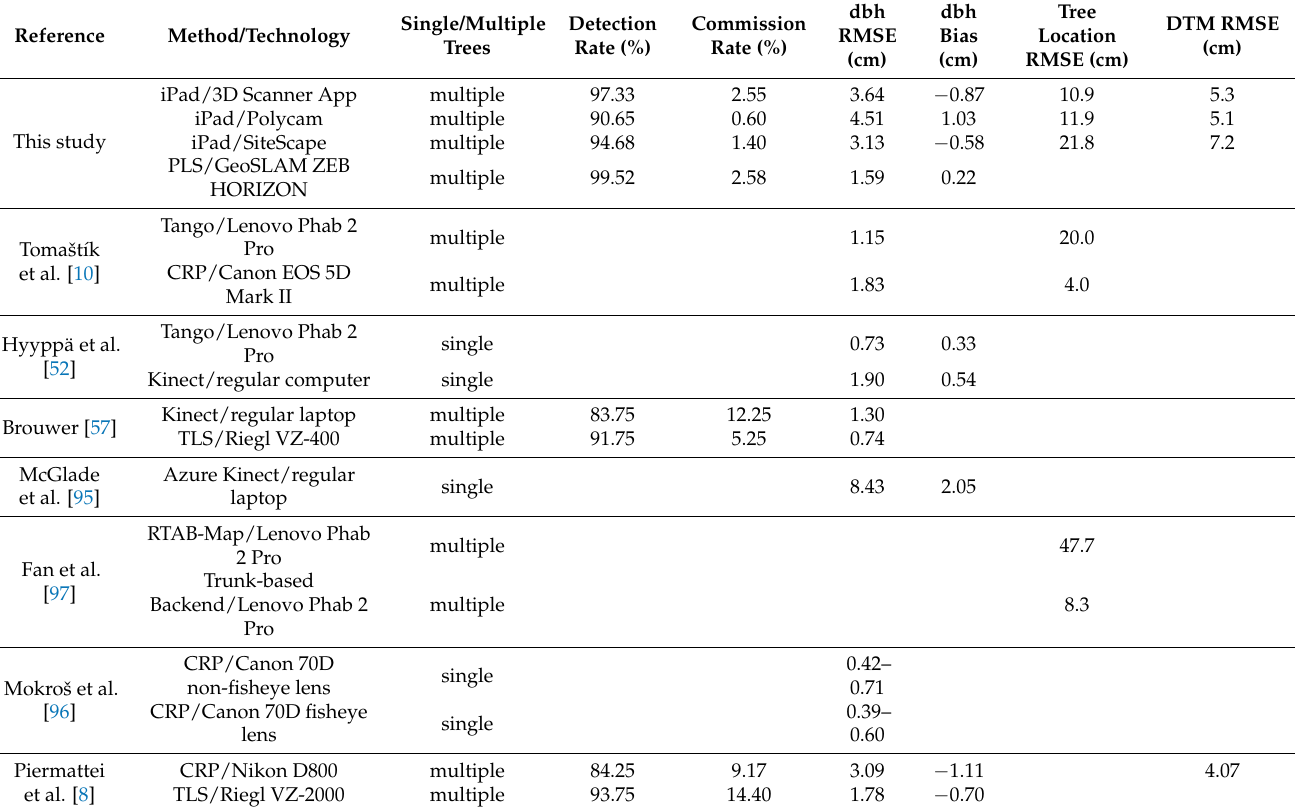
Table 4. Comparison of current results with previous